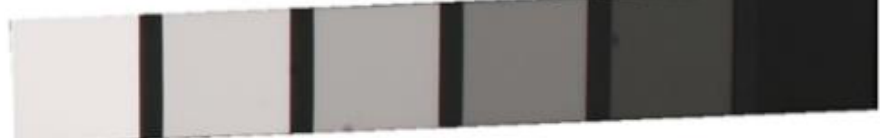
Figure 7. The grayscale area of the color checker obtained from the image.